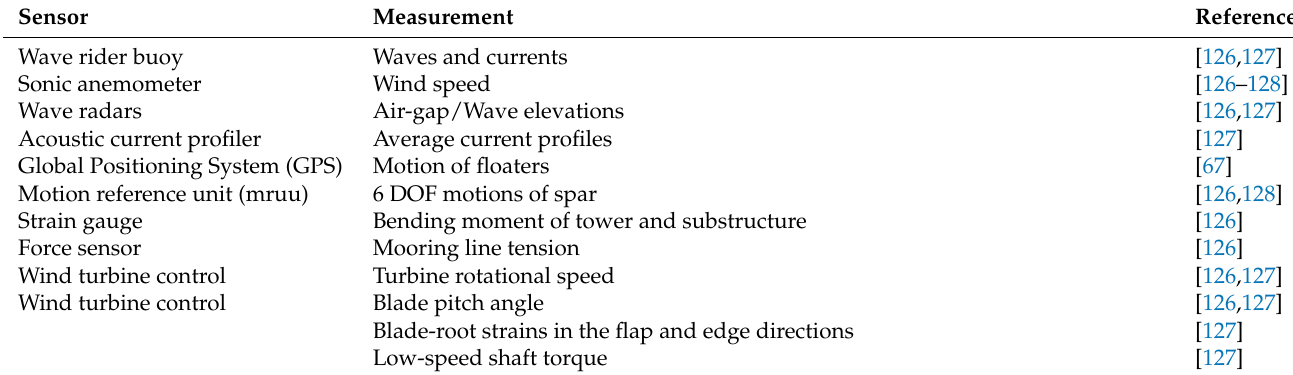
Table 3. Sensors and field measurements of